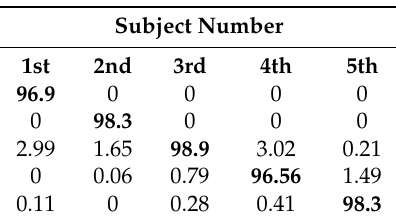
Table B2. The confusion matrix using DFA classifier after artifact removal for 10 randomly chosen features permutation using domain knowledge (5 joints’ ratio, 5 joints’ length).